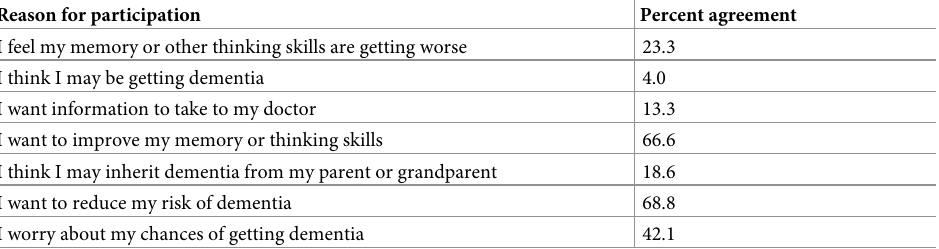
Table 2. Percentages of participants responding in the affirmative to statements about the reasons for undertak- ing the Preventing Dementia MOOC. Reason for